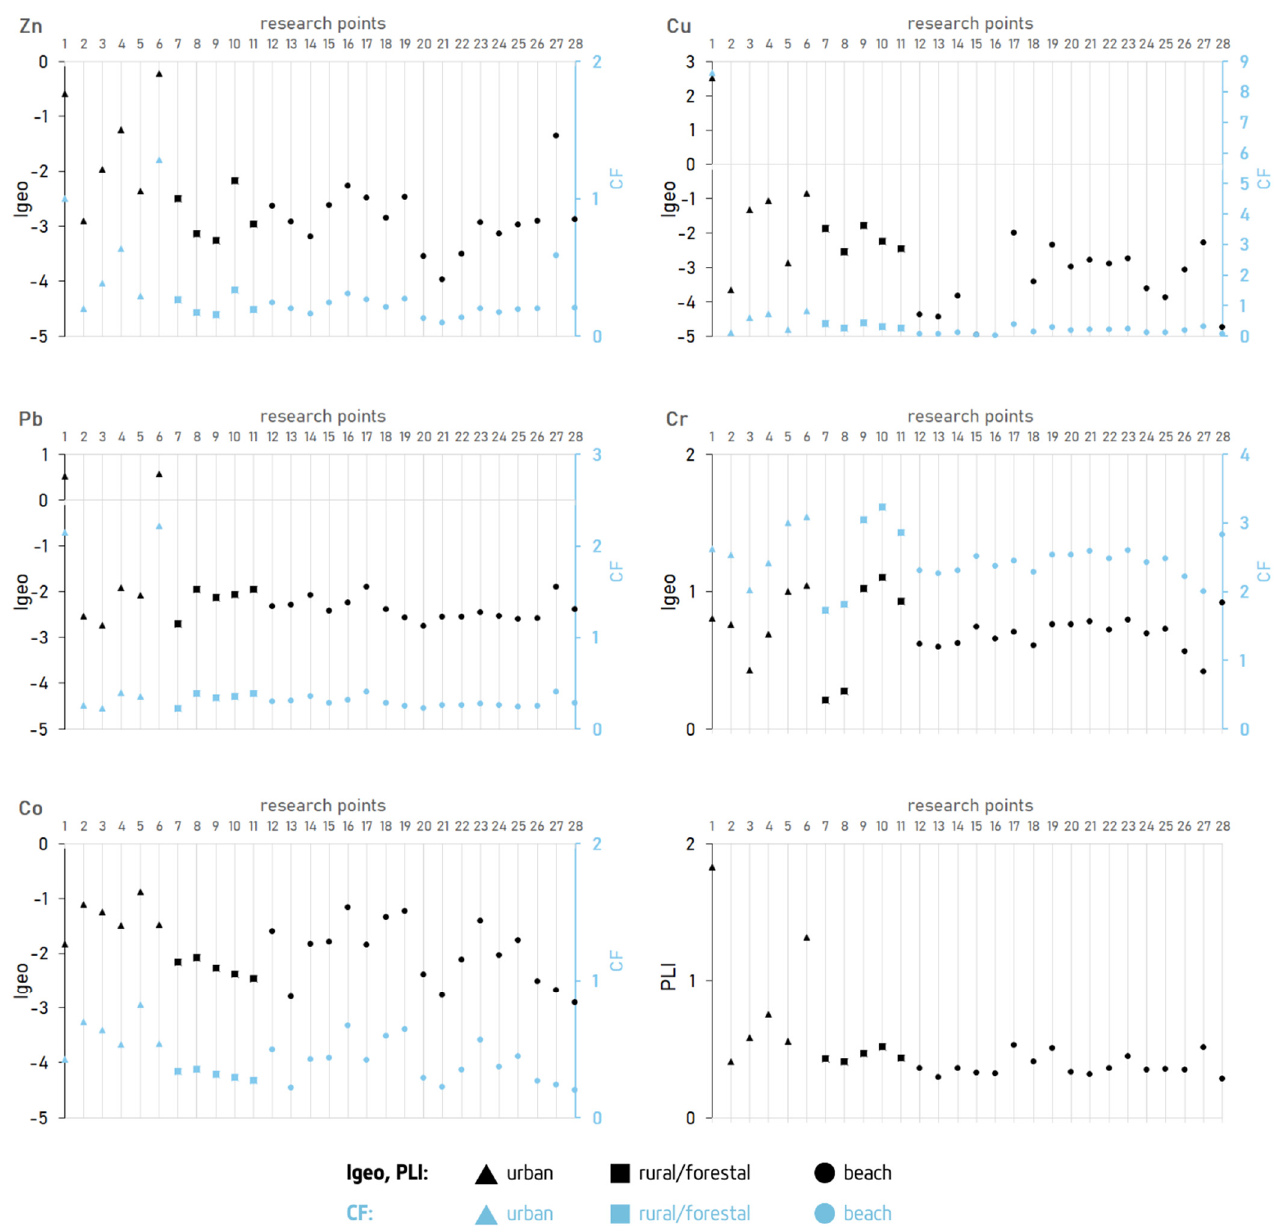
Figure 2. I geo , CF and PLI values for the PTEs analyzed.